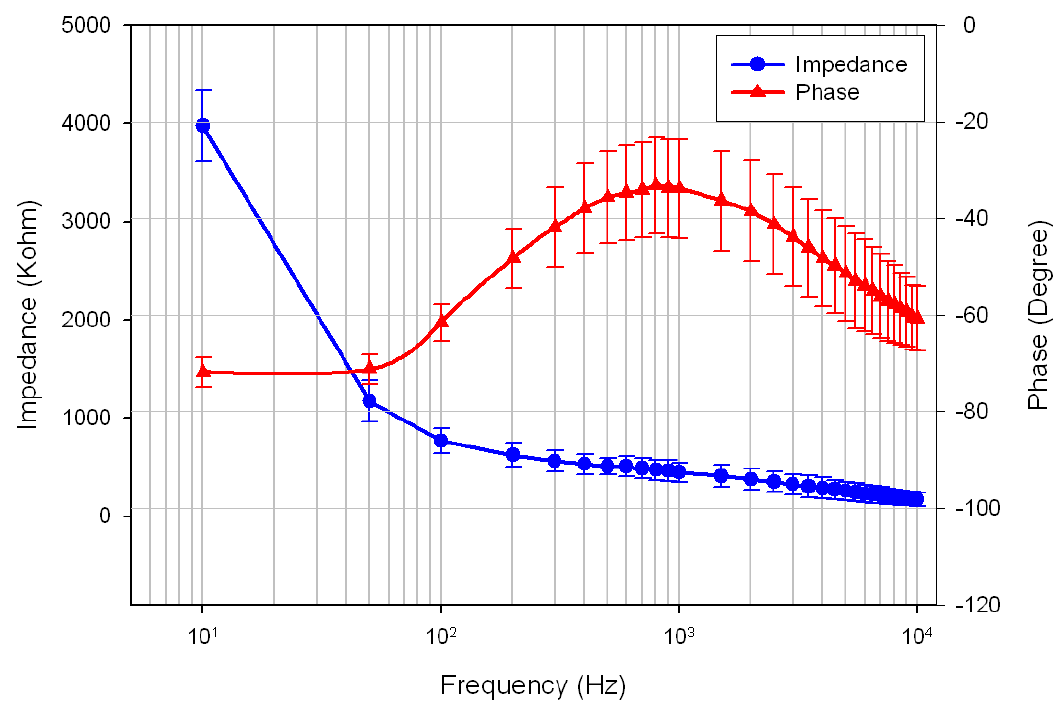
Figure 5. The electrode impedance spectroscopy of fabricated microprobe array in physiologic saline solution. Means and standard deviations are given (n =